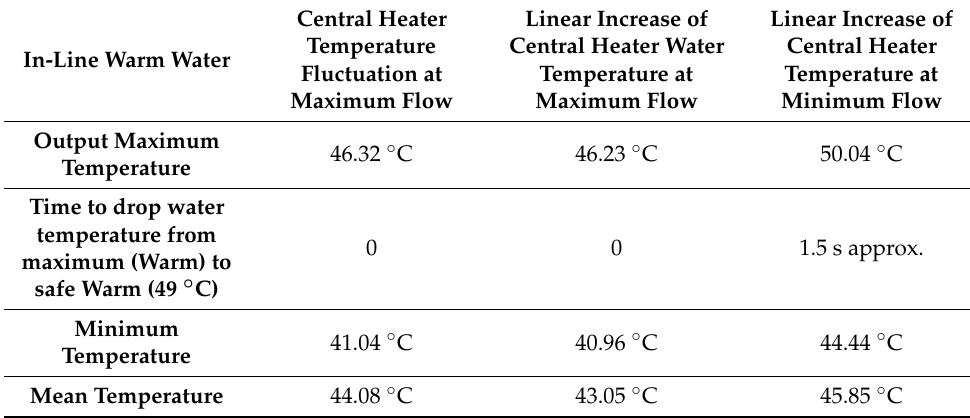
Table 4. Normal operation test cases observations